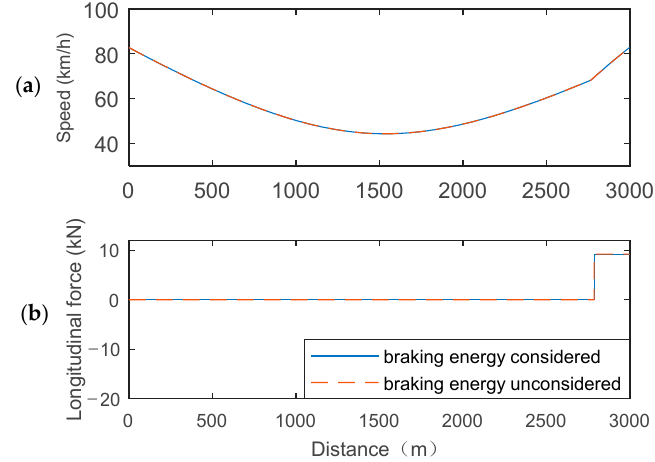
Figure 5. Optimum speed profile and its corresponding control inputs; time factor σ = 0 and duration t f = 194 s/194 s. ( a ) Speed profile; ( b ) control input profile.